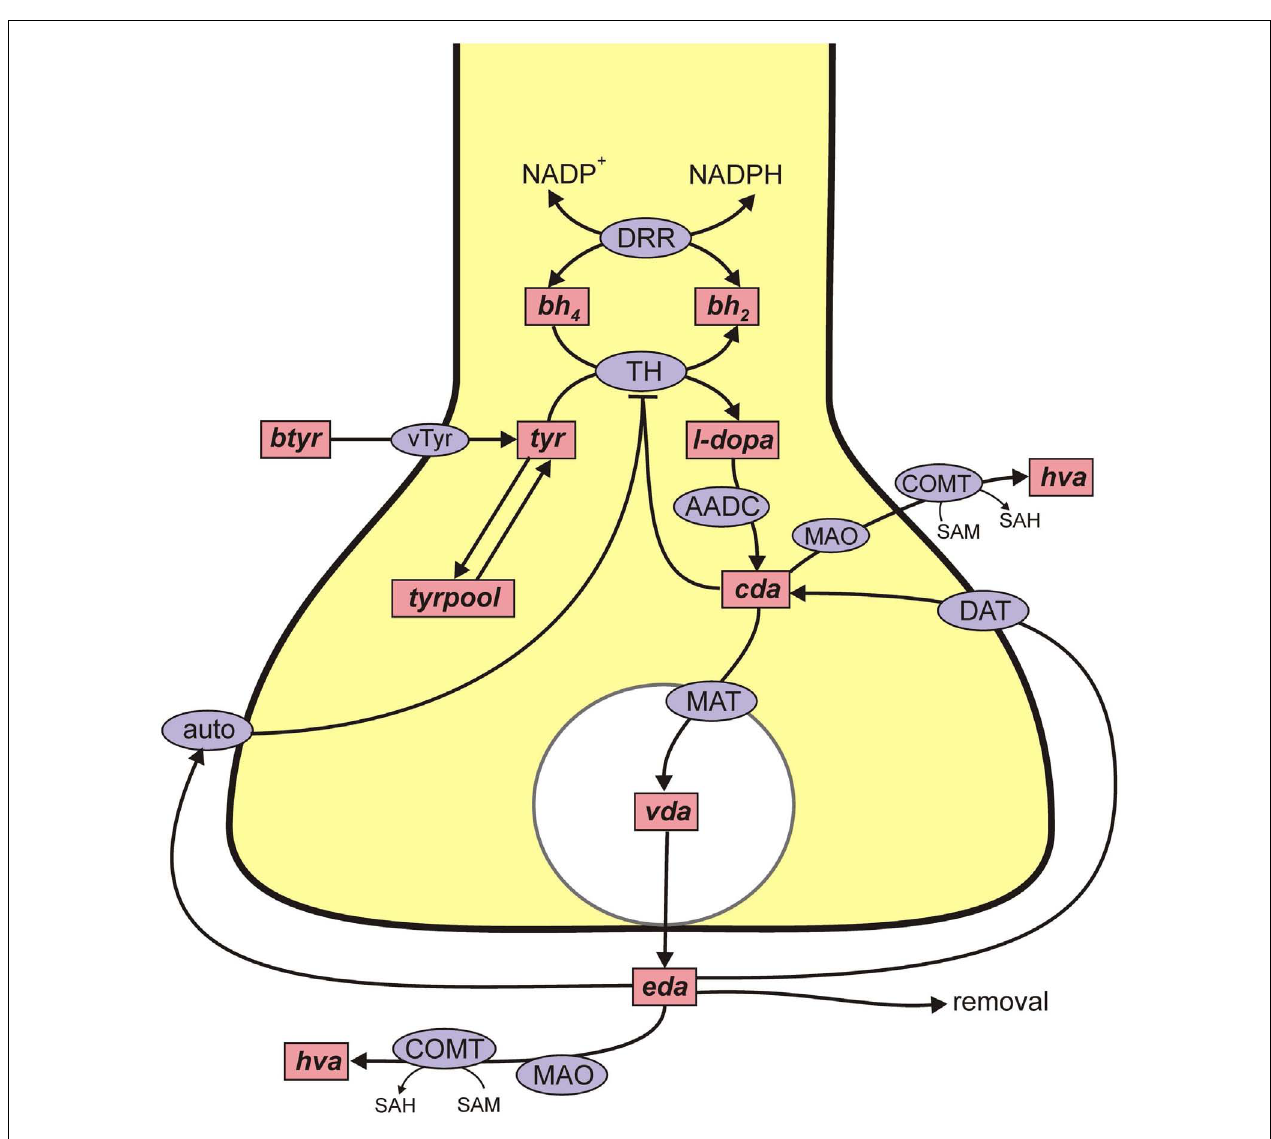
MAO, monoamine oxidase; COMT, catacholamine methyltransferase. Removal means uptake by capillaries or glial cells or diffusion out of the system. In TableA1 various shorter names are used for the dopamine variables in the dopamine terminal and the variables all start with “d” to distinguish them from the dopamine variables in the 5HT terminal and cell